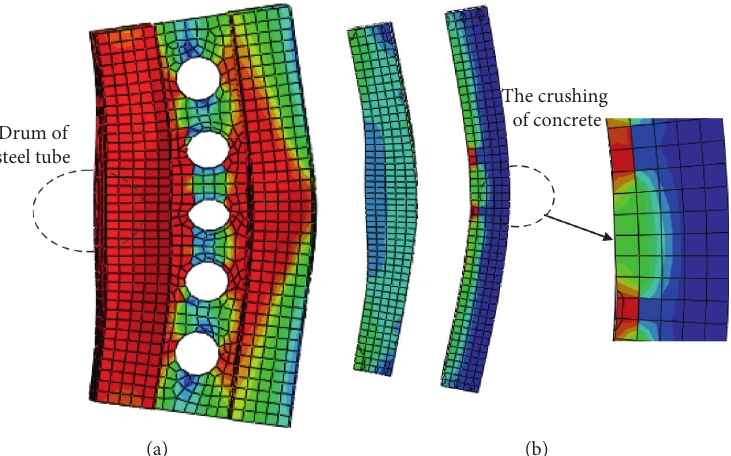
Figure 15: Stress cloud diagram of parts for specimen STHCC-1 in a state of failure. (a) The deformation of steel tube. (b) The deformation of concrete.